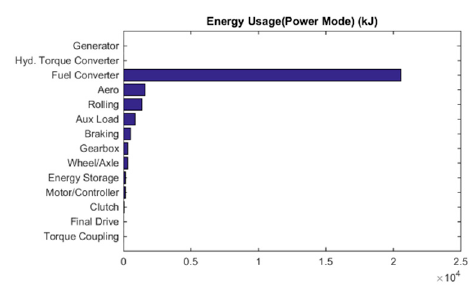
Figure 16. Motor torque-speed.